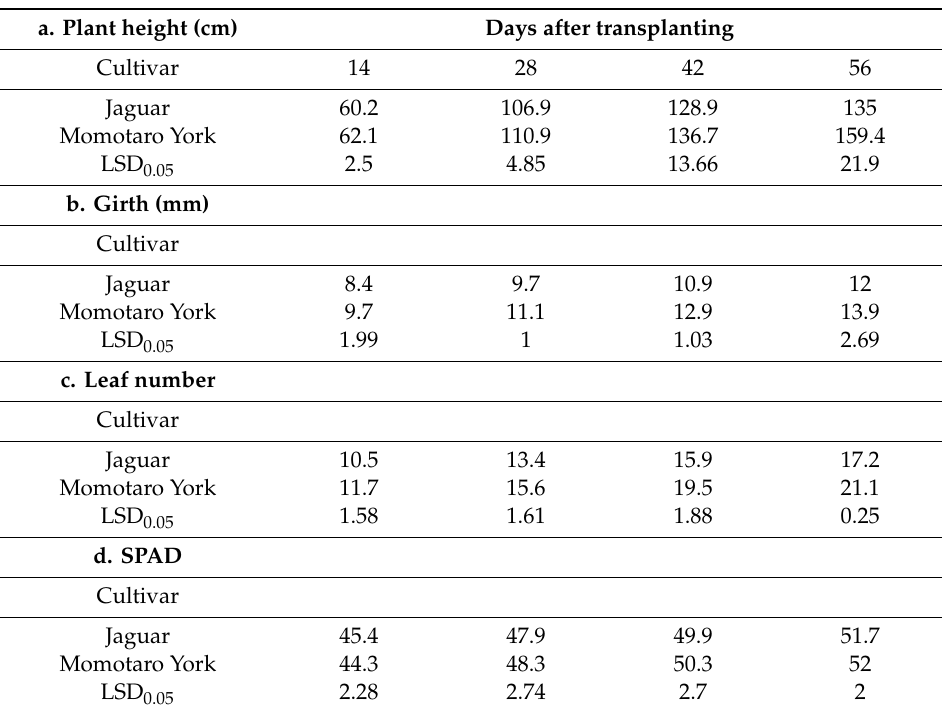
Table 1. Morphological characteristics of tomato as influenced by low-node order pinching at high plant density (LN&HD).